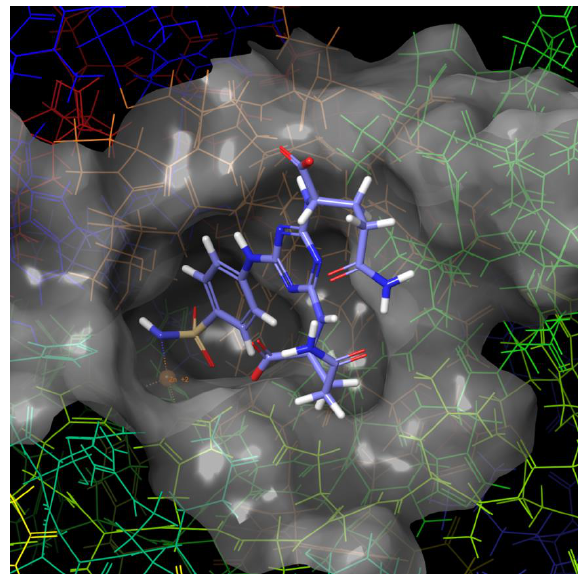
Figure 4. Molecular surface of the binding site of hCA IX with docked compound 7 (with Gln).